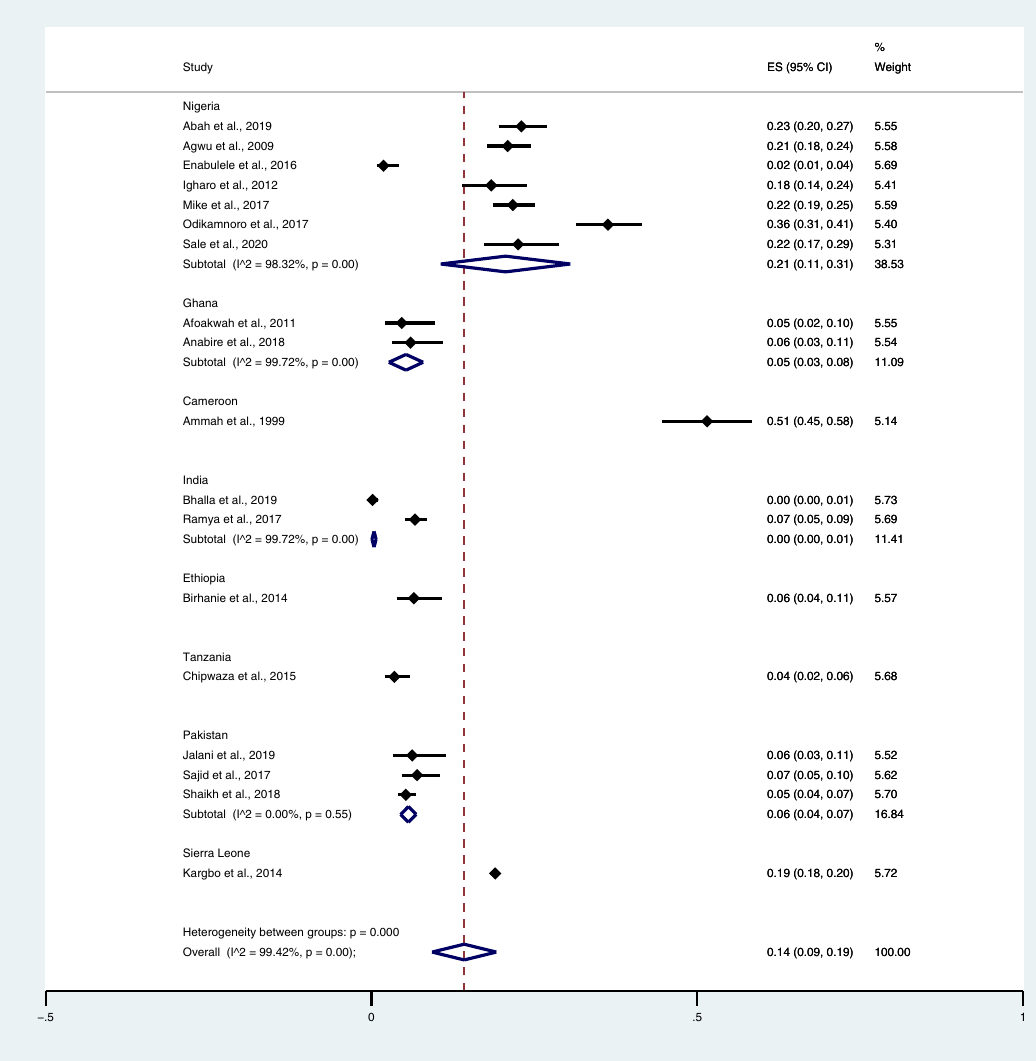
Figure 3. Pooled prevalence of typhoidal/NTS and malaria co-infection using the Widal test for the identification of Salmonella spp. infection stratified by countries. ES proportion estimate (multiply 100 units for interpreted as prevalence estimate), CI confidence